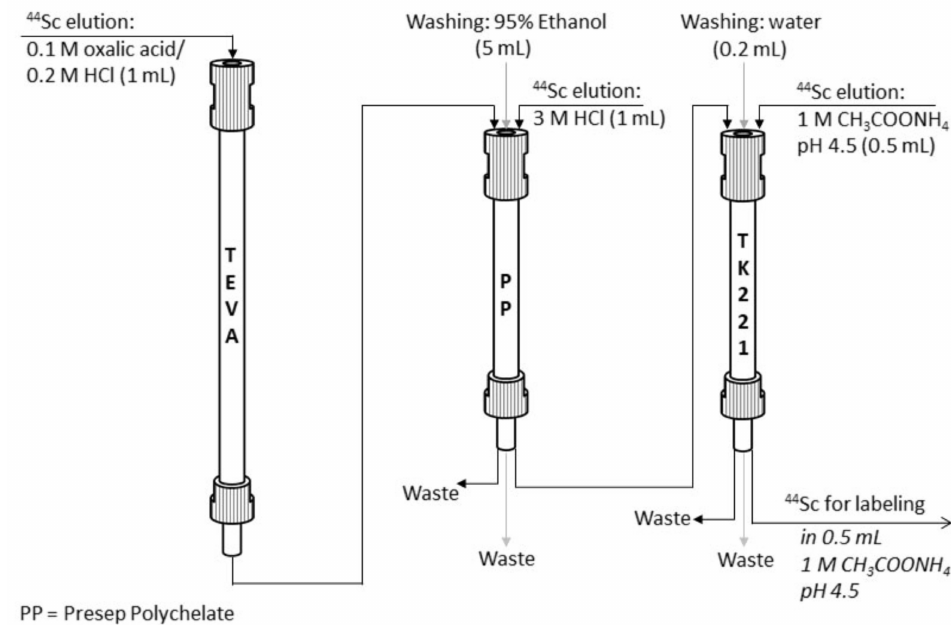
Figure 13. The scheme of proposed method for TEVA-based 44 Ti/ 44 Sc generator eluate post-processing.